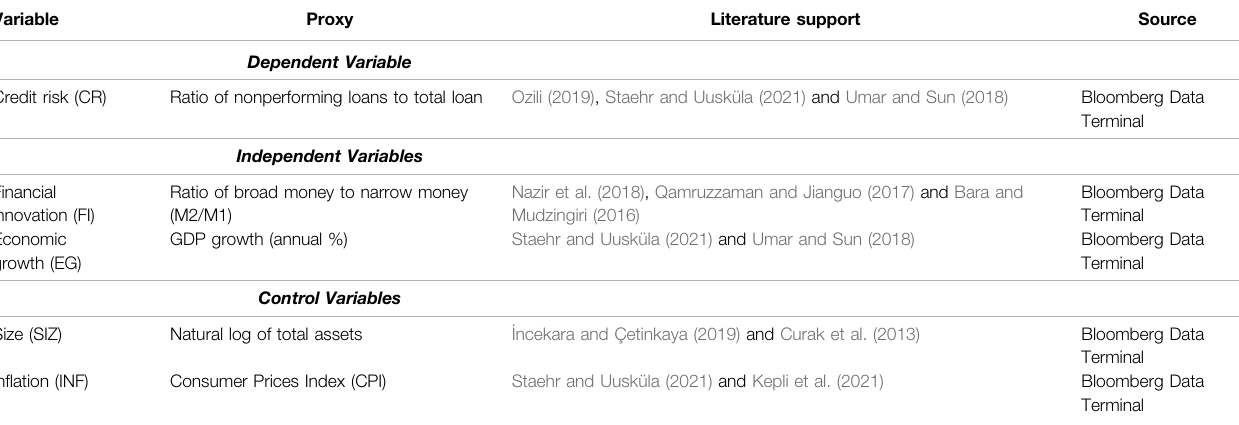
TABLE 2 | Selected variables and their